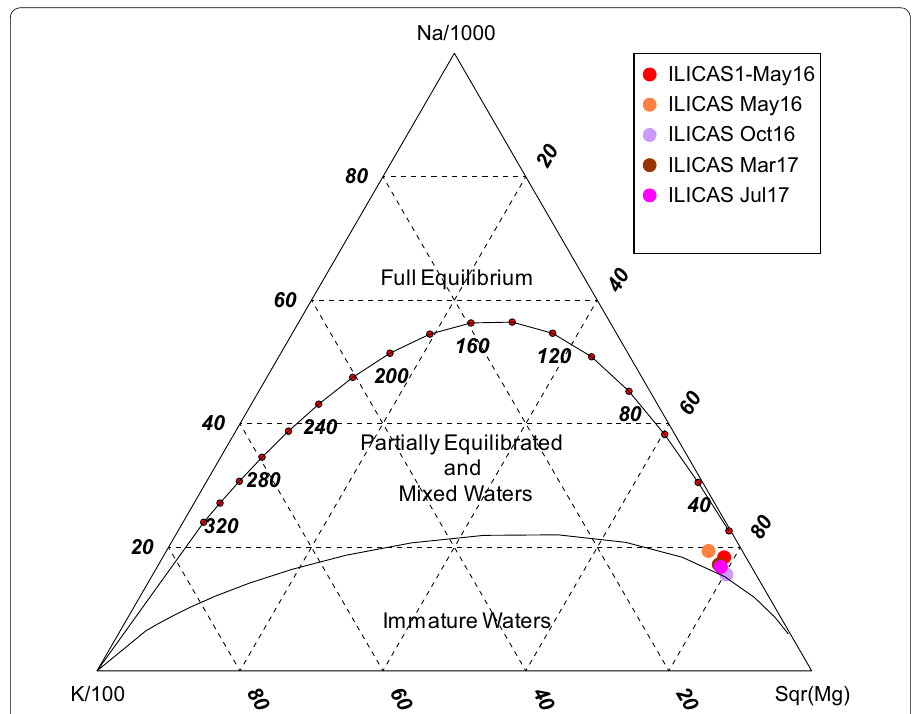
Fig. 10 Na–K–Mg ternary diagram (Giggenbach 1988) for the thermal waters of the Şavşat Geothermal